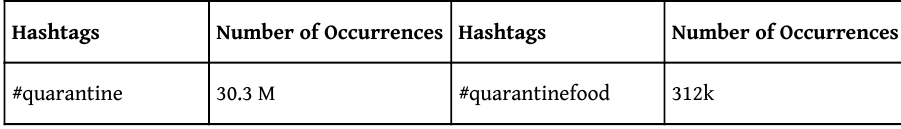
Table 3: Chosen hashtags under the basetag #quarantine